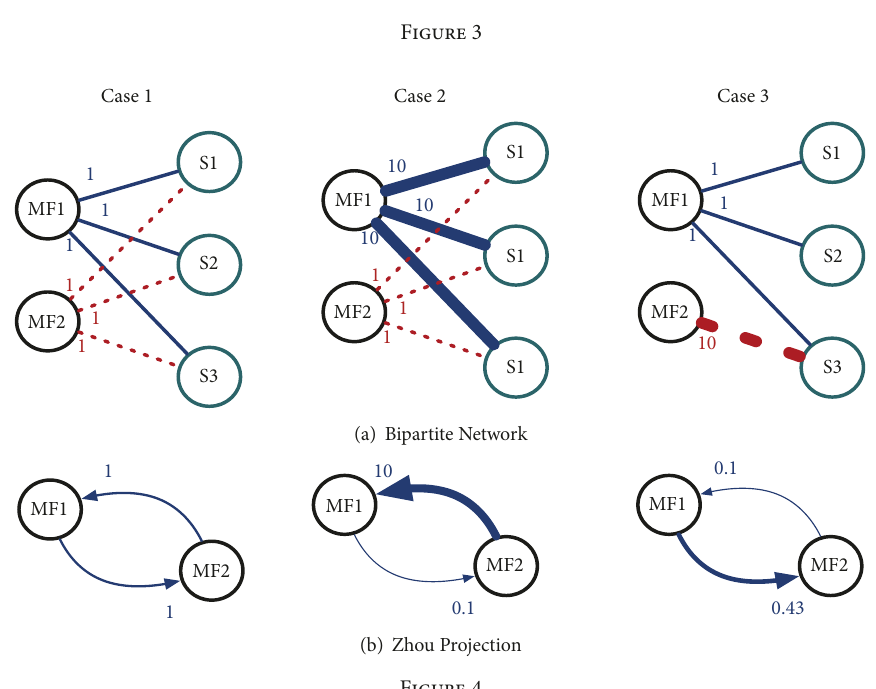
Strength in out (b) Boxplots of logarithms of strengths-in and strengths-out of the bipartite network projection ofmutual funds, 24months before and after the crisis (March 2007, 2009, and